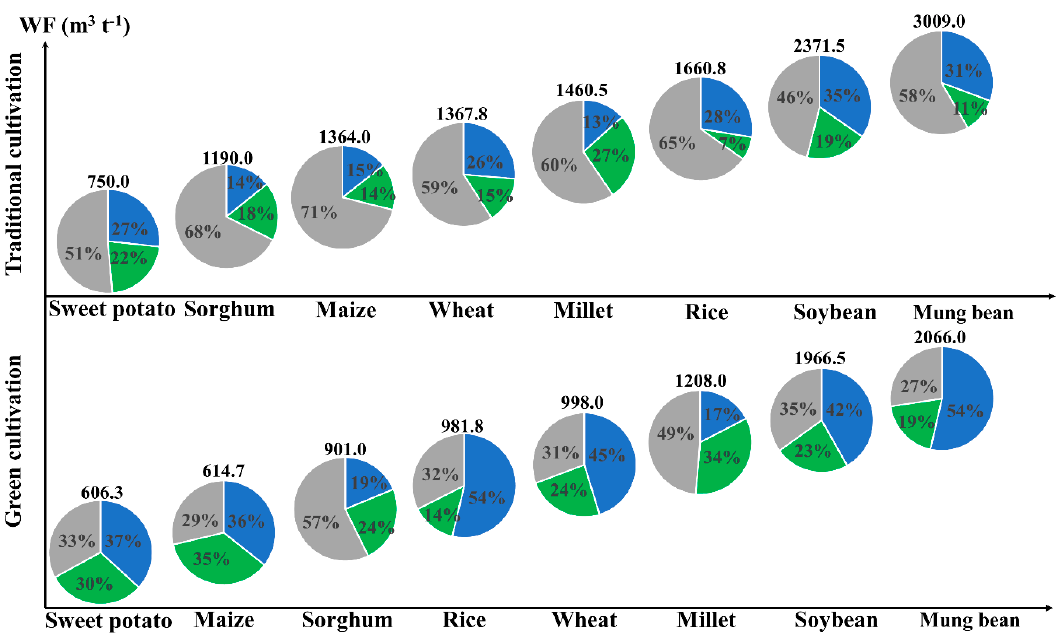
Figure 7. Composition of water footprint components in different crops under green and traditional cultivations. The value of blue, green and grey colors in each chart indicates the proportion of WF green , WF blue and WF grey to WF total , respectively.